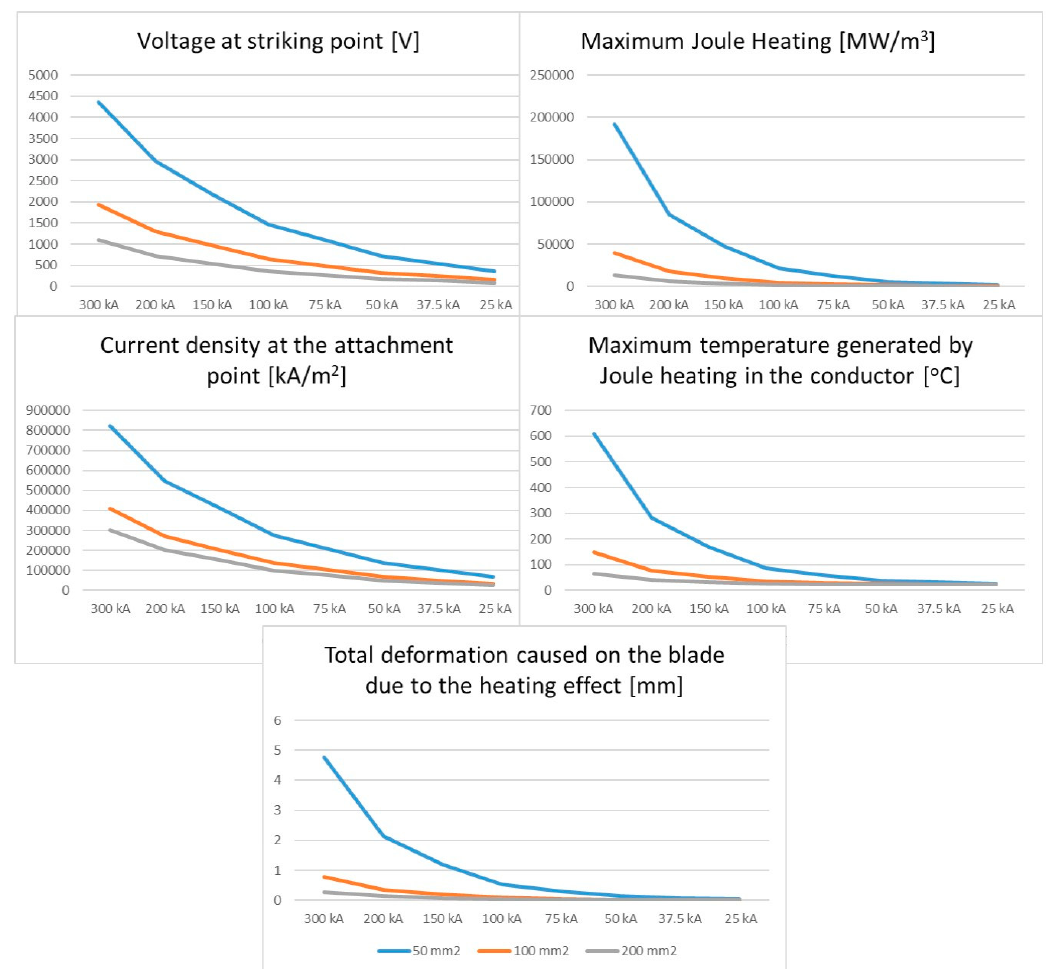
Figure A1. Plotted results from conventional simulations.